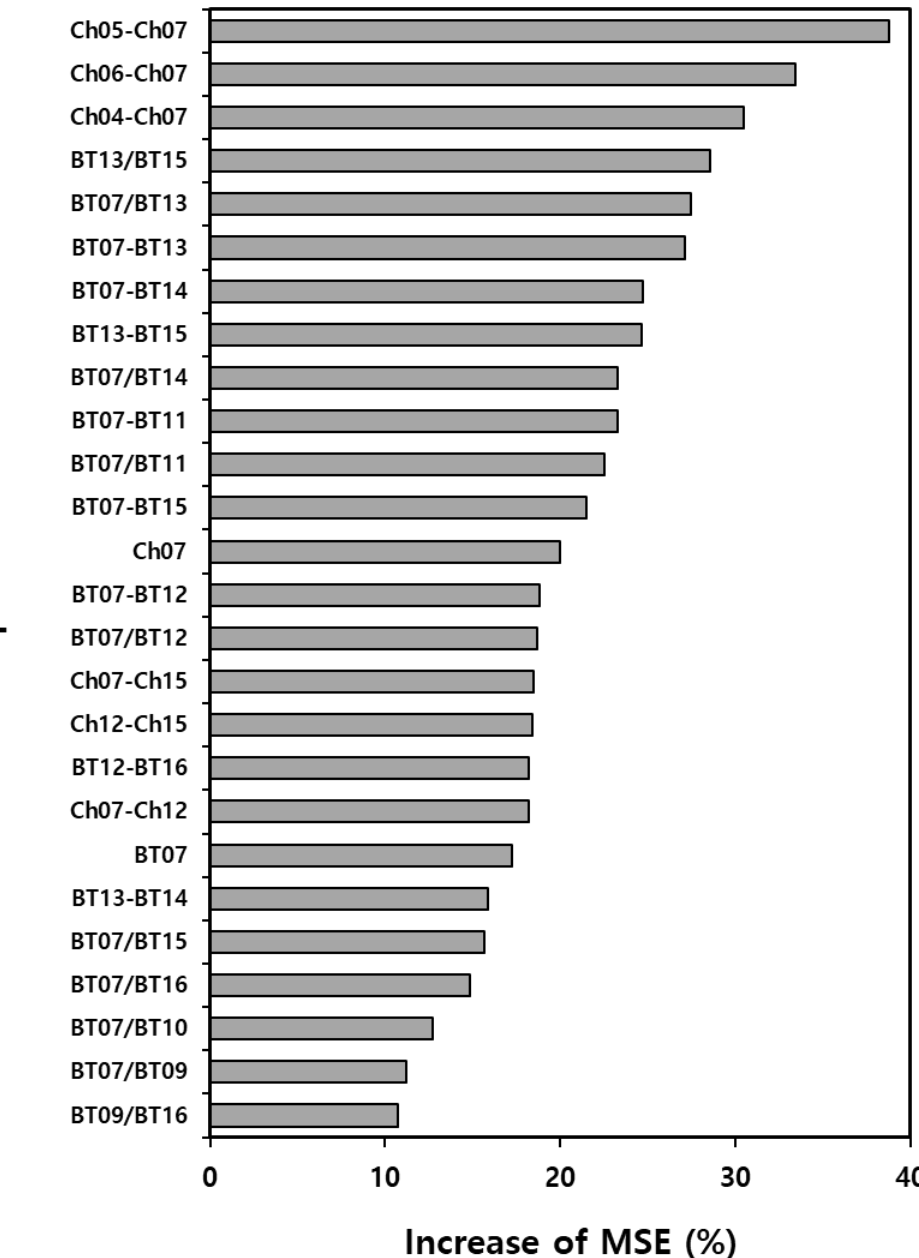
Figure 4. Variable importance for removal of false alarms using the RF model. Increase of mean squared error (MSE) was calculated using out of bag (OOB) data. More detailed information about the increase of MSE%) is given in Section